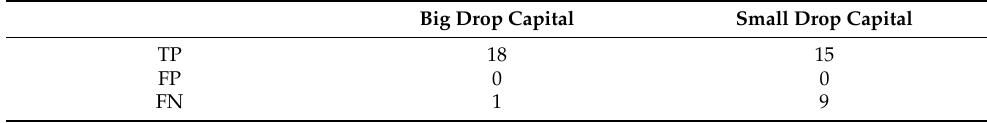
Table 3. Overview of the qualitative evaluation of the drop capital detection. Big Drop Capital Small Drop Capital TP 18 15 FP 0 0 FN